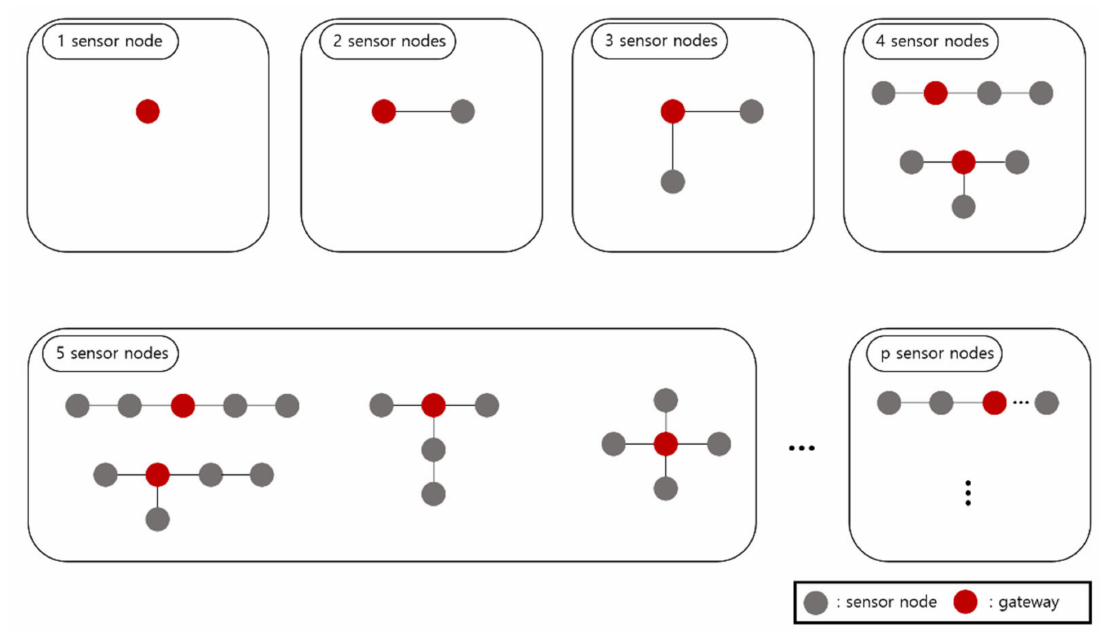
Figure 1. Example of the cost